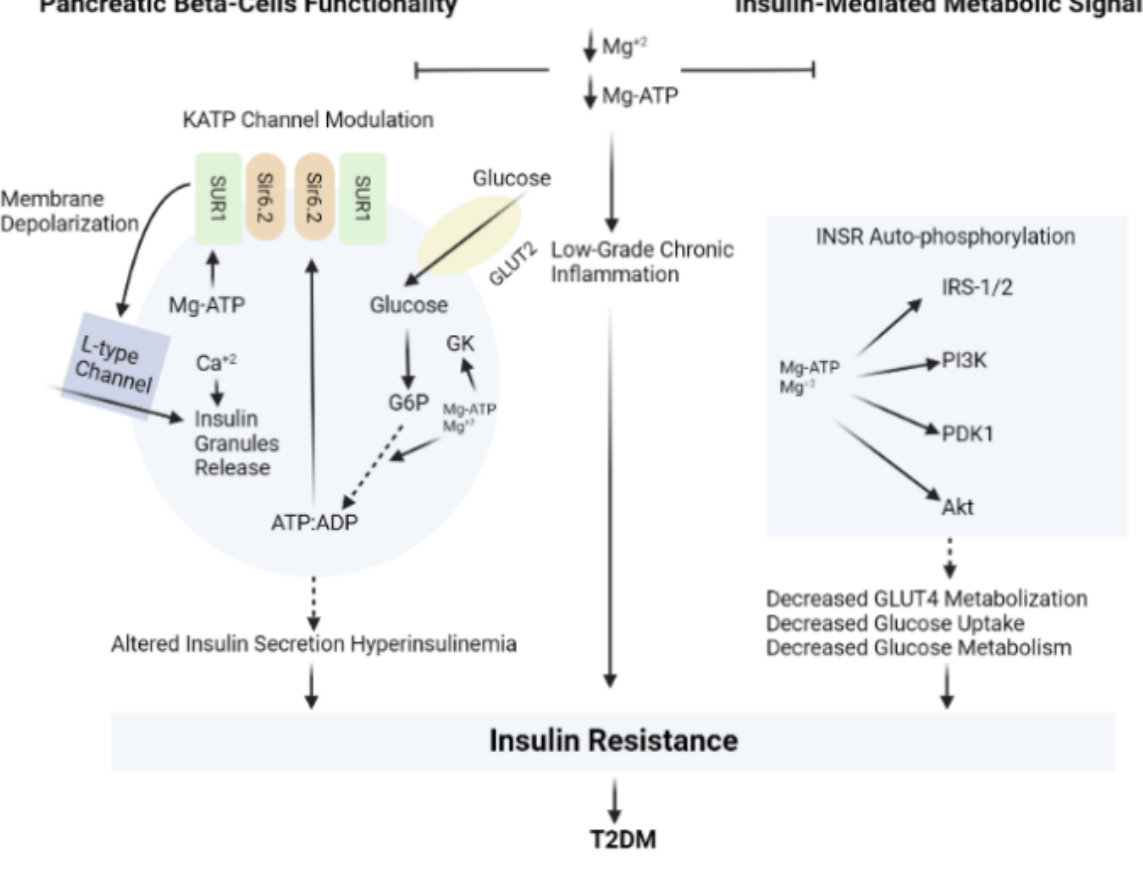
Figure 4. The relationship between magnesium (Mg) and insulin signalling and resistance.